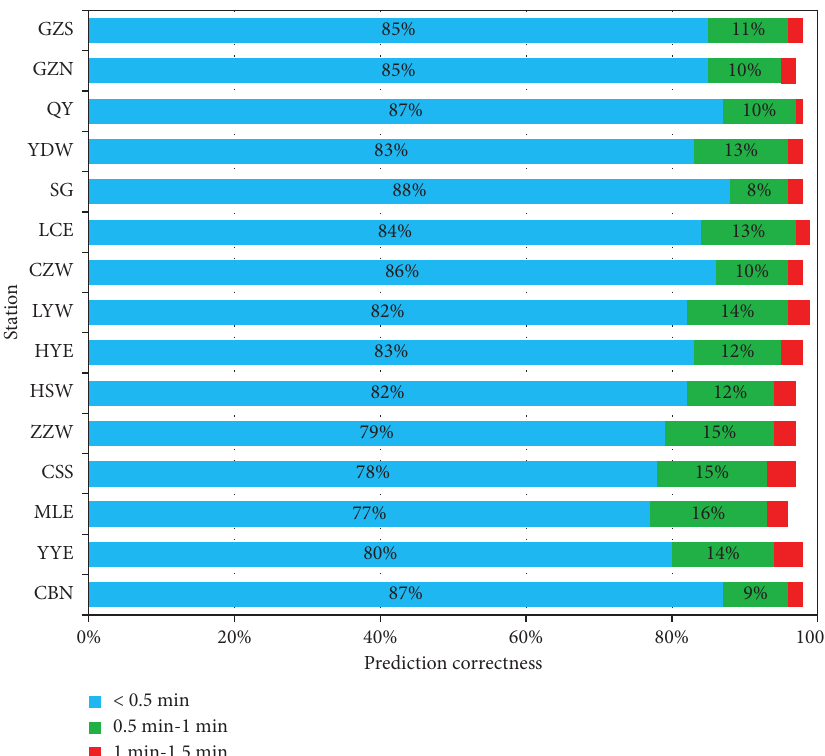
Figure 8: Prediction correctness for each station on test